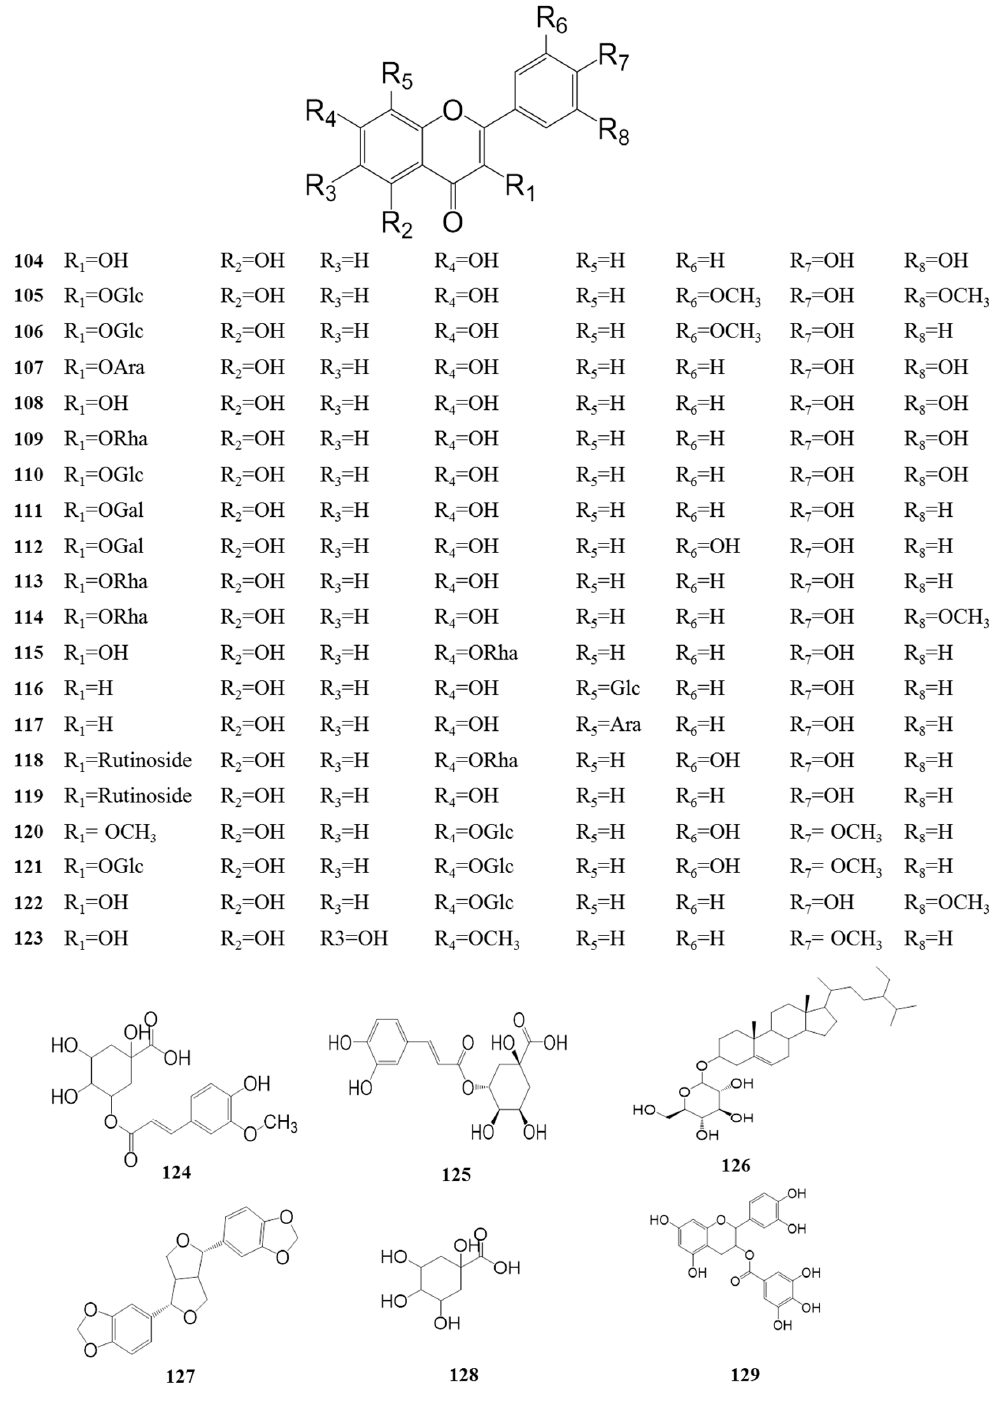
Figure 5. Chemical structures of the flavonoids in Z. bungeanum .